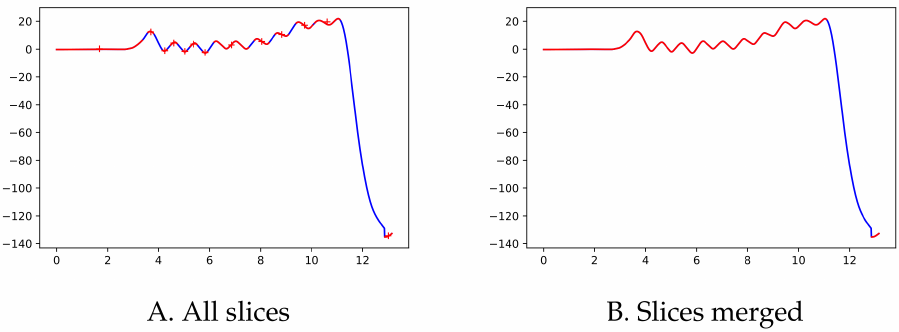
Figure A4. A participant in the HC group, fast walk experiment. In blue, smoothed values of the pelvis rotation angle; in red, identified slices.